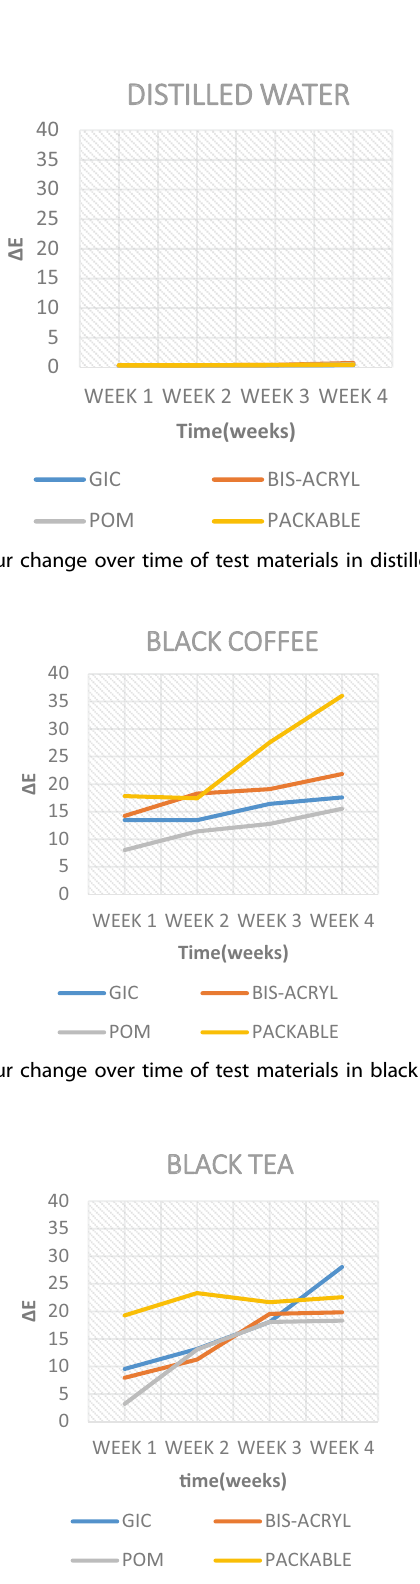
Fig. 9 Colour change over time of test materials in black tea.